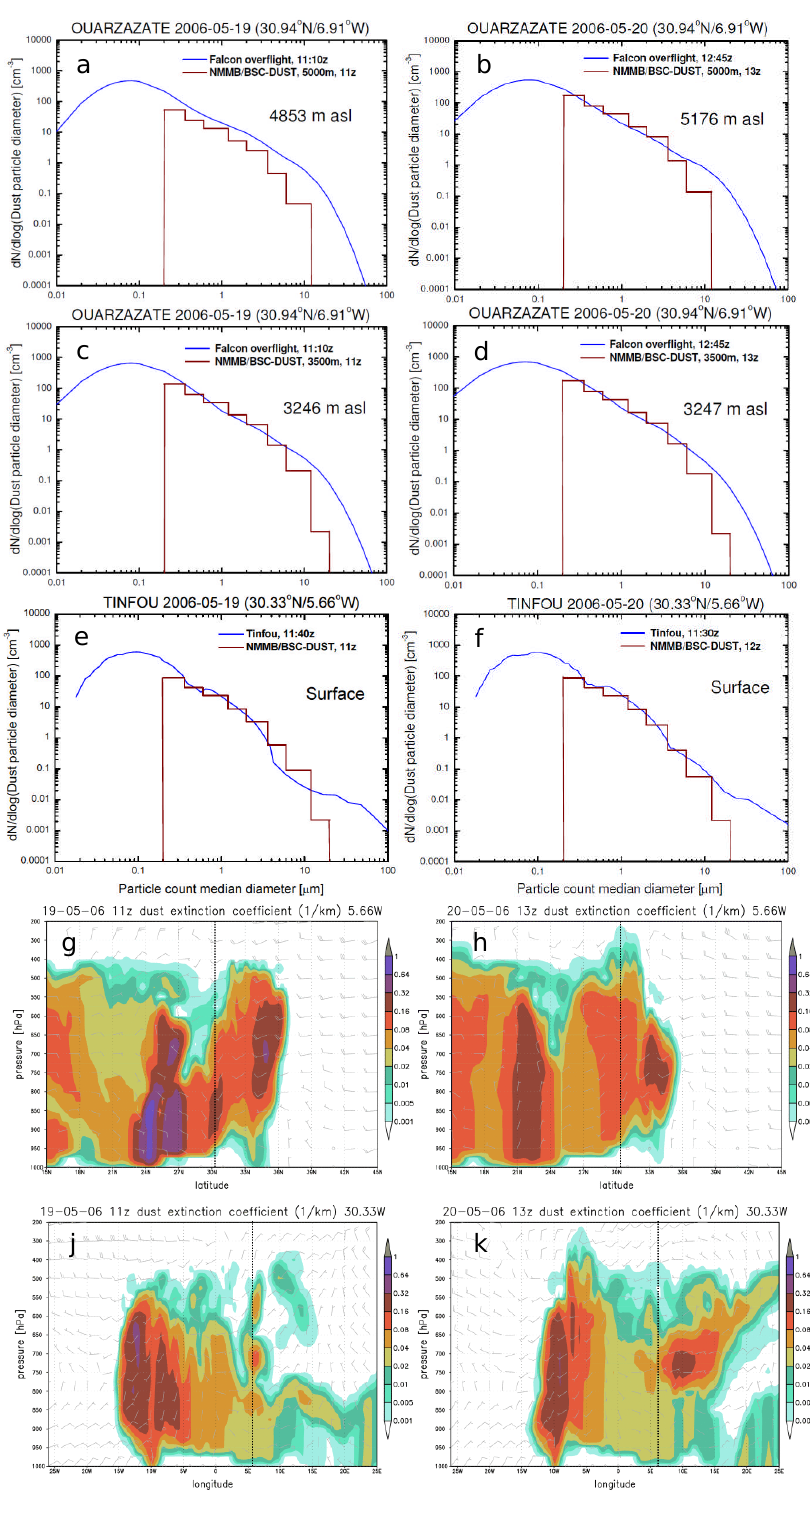
Fig. 14. Measured (blue line) and model derived particle size distribution (brownish line) at 19 and 20 May 2006 over Ouarzazate at 5km (a, b) and 3km (c, d) altitude, and at the surface in Tinfou (e, f) . Notice the truncated ordinate, causing the largest model size class to be out of range (a, b) . Complementary, the latitudinal (g, h) and the longitudinal (j, k) model extinction cross-section and wind bars are shown. The location of the Tinfou/Ouarzazate region is marked with the dotted